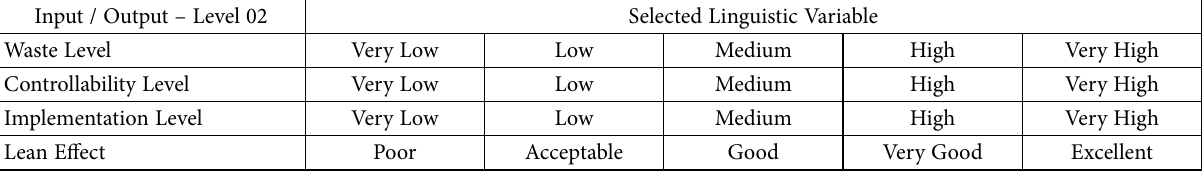
Table 3. Linguistic variables for used inputs and outputs in Level 02 of